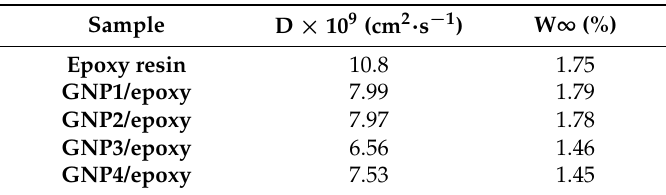
Table 2. Water diffusion coefficients (D) calculated by Fick model and weight fraction of water at the saturation equilibrium (W ∞ ).